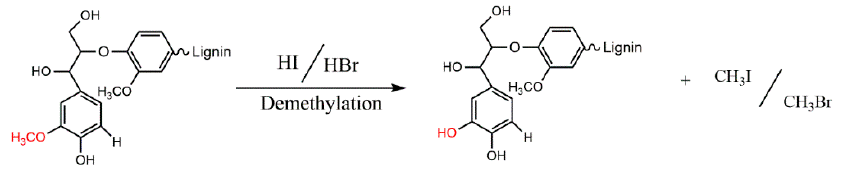
Figure 1. Schematic reaction process of the demethylation of lignin with halogen acids.